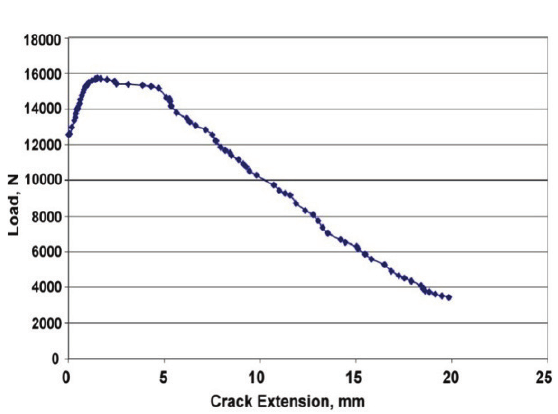
Figure 5: The mesh distribution for Arcan fixture and the specimen